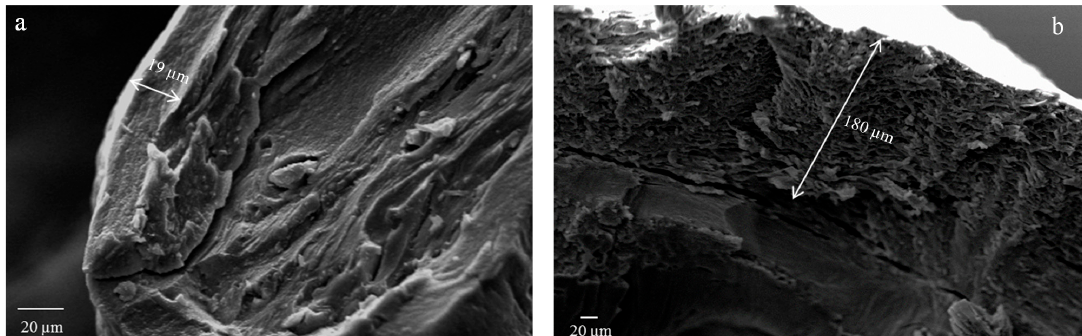
Figure 1. SEM microphotographs at different magnification of formulations: F1 ( a , e ), F2 ( b , f ), F3 ( c , g ) and F5 ( d , h ).